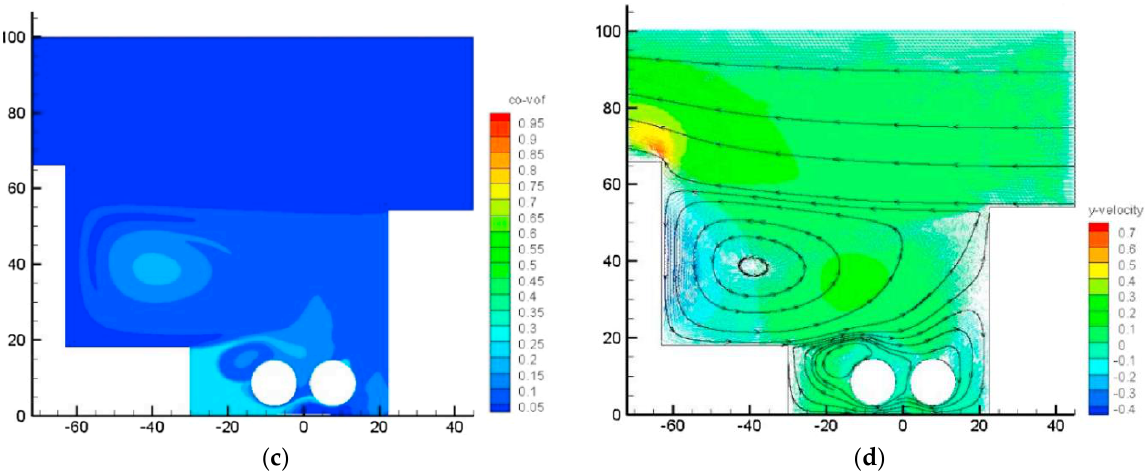
Figure 5. Influence of street canyon morphology on pollutant and airflow field. ( a ) PM2.5 concentrations without trees at h = H/3 [10]. ( b ) PM2.5 concentrations with trees at h = H/3 [10]. ( c ) Pollutant concentration under southwest wind at scenario A [34]. ( d ) Flow velocity under southwest wind at scenario A [34].